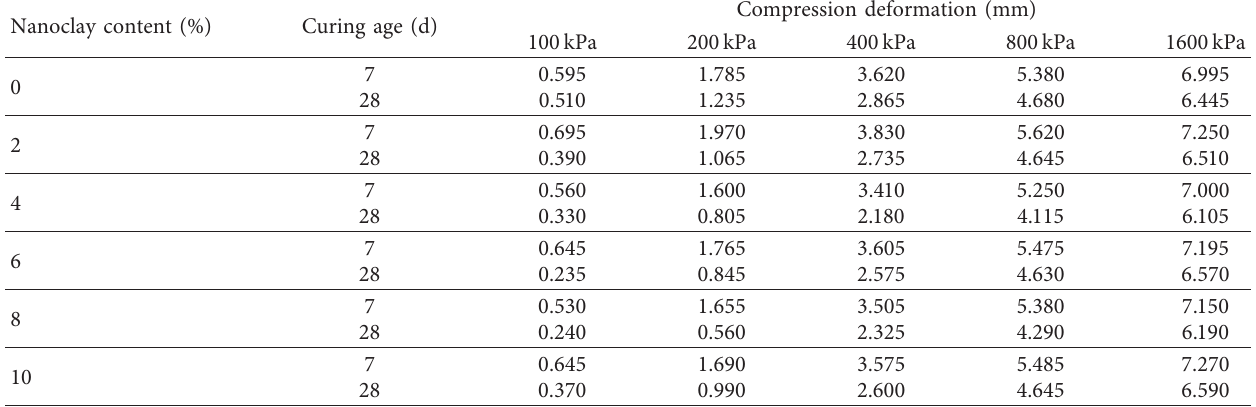
Table 7: Compression of NCS at different consolidation pressures.